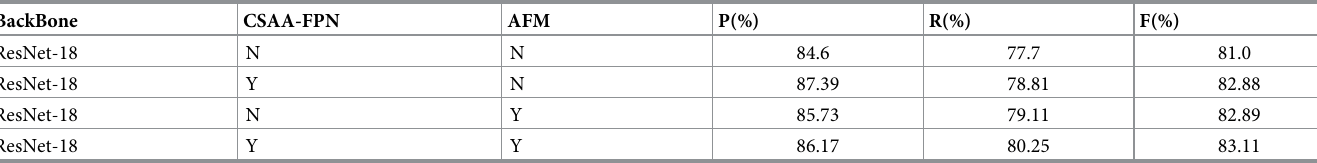
Table 1. The ablation experiment on CTW1500. “P”, “R” and “F” respectively stand for “precision”, “recall” and “F-measure”, “N” means that the module is not used, and “Y” means that the module is used. BackBone